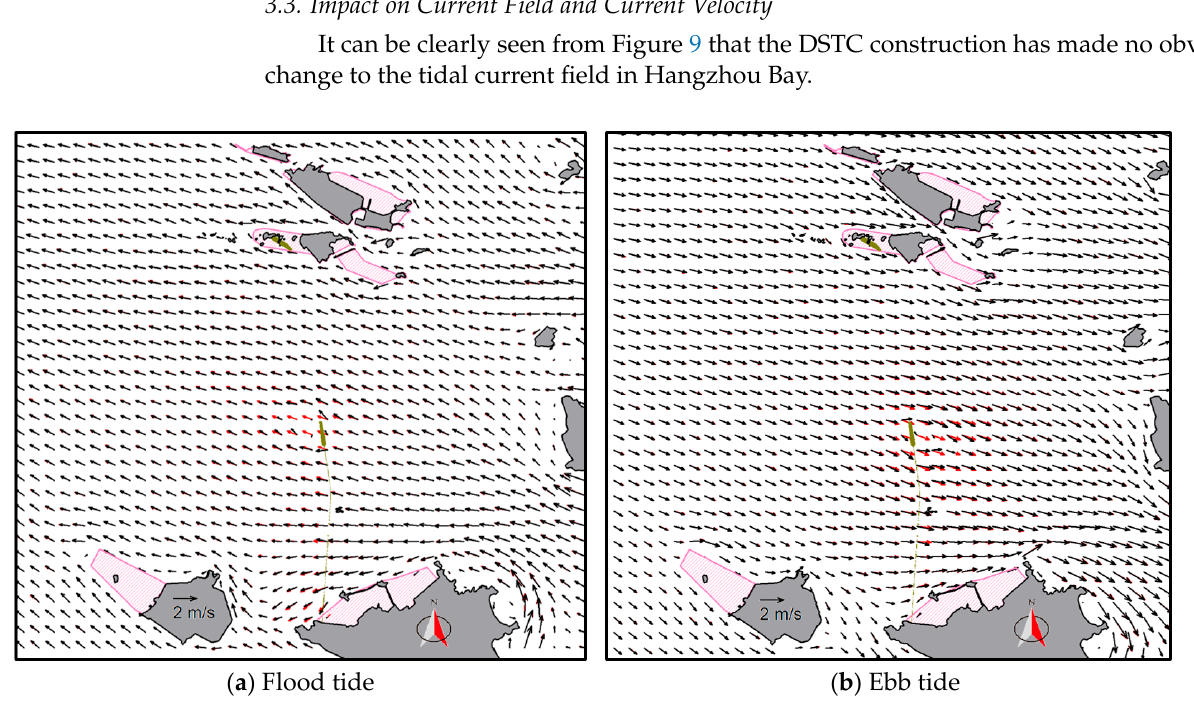
Figure 9. Comparisons of the simulated current fields (red and black arrows are the current fields before and after the DSTC, respectively).